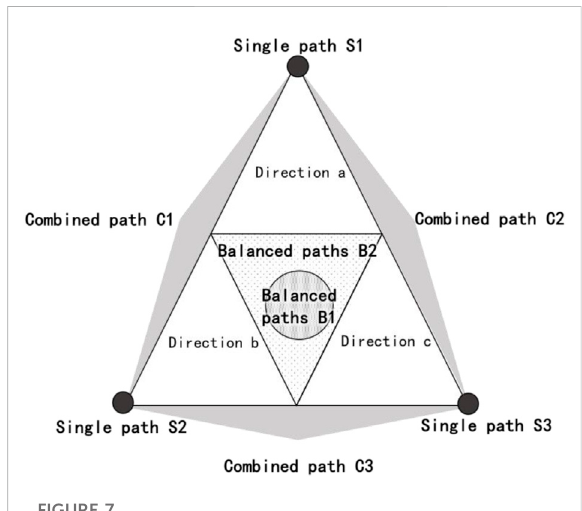
FIGURE 7 Classi fi cation of transformation and upgrading